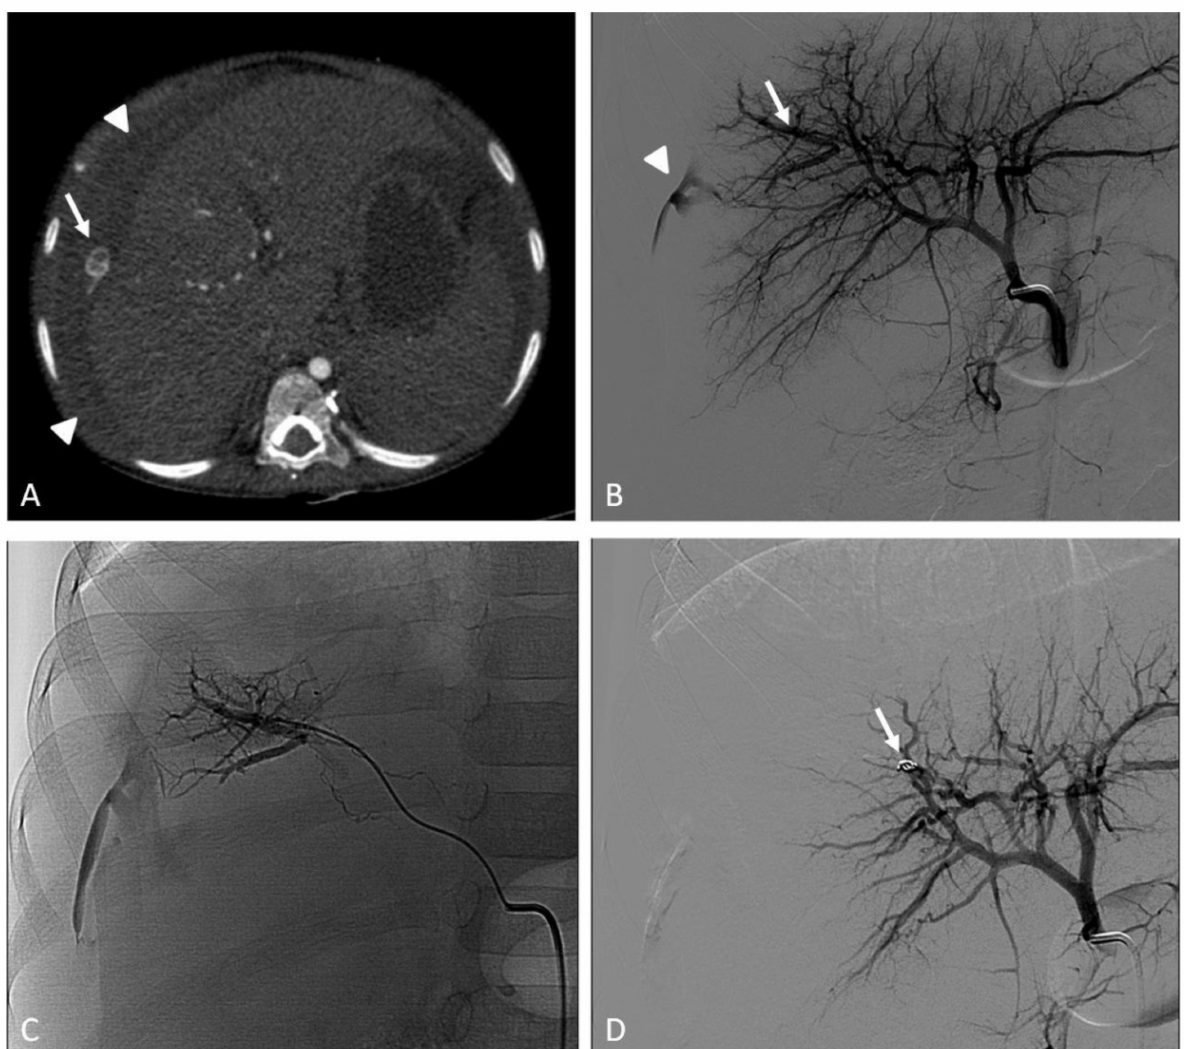
Figure 2. Transcatheter particle embolization of iatrogenic hepatic bleeding after percutaneous needle biopsy in a 9-year-old male. ( A ) Axial CTA image shows a perihepatic fluid collection (arrowheads) with contrast medium extravasation (arrow), consistent with active arterial bleeding from the site of percutaneous biopsy in the right liver lobe. ( B ) Selective hepatic artery digital subtraction angiography (DSA) performed with a 4F catheter shows the presence of an arterio-portal shunt with opacification of peripheral right portal branches (arrow) and contrast extravasation (arrowhead) from the lateral hepatic margin. ( C ) Fluoroscopic image shows superselective coaxial 1.9F microcatheterization of the artery feeding the arterio-portal shunt and the bleeding. ( D ) Selective hepatic artery DSA demonstrating disappearance of the bleeding after 3-mm coil (arrow)